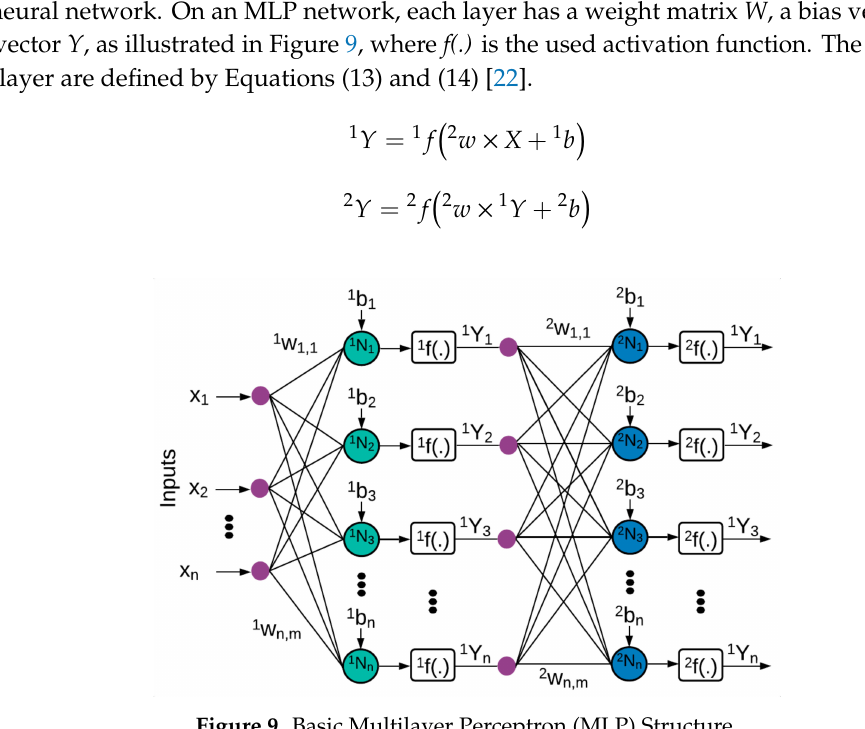
Figure 9. Basic Multilayer Perceptron (MLP)